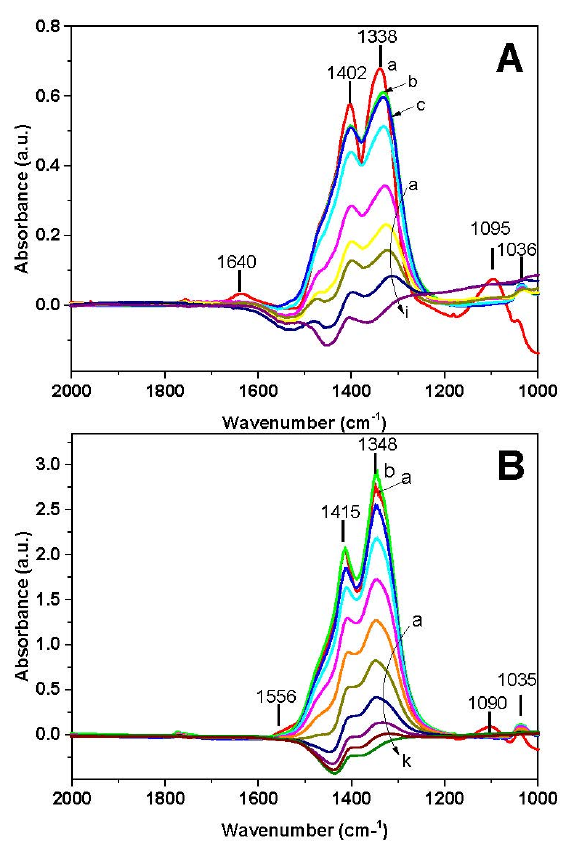
Figure 10. Operando FT ‐ IR spectra obtained during NH 3 ‐ TPSR experiments with NH 3 (1000 ppm) from 40–400 °C (4 °C/min) after NO/O 2 adsorption at 350 °C over ( A ) Rh ‐ BaO/Al 2 O 3 at: ( a ) 40 °C; ( b ) 275 °C; ( c ) 283 °C; ( d ) 291 °C; ( e ) 300 °C; ( f ) 308 °C; ( g ) 316 °C; ( h ) 333 °C; ( i ) 400 °C, and ( B ) Pt ‐ BaO/Al 2 O 3 at: ( a ) 40 °C; ( b ) 171 °C; ( c ) 196 °C; ( d ) 204 °C; ( e ) 213 °C; ( f ) 221 °C; ( g ) 229 °C; ( h ) 237 °C; ( i ) 246 °C; ( j ) 254 °C; ( k ) 303 °C (rig#3).